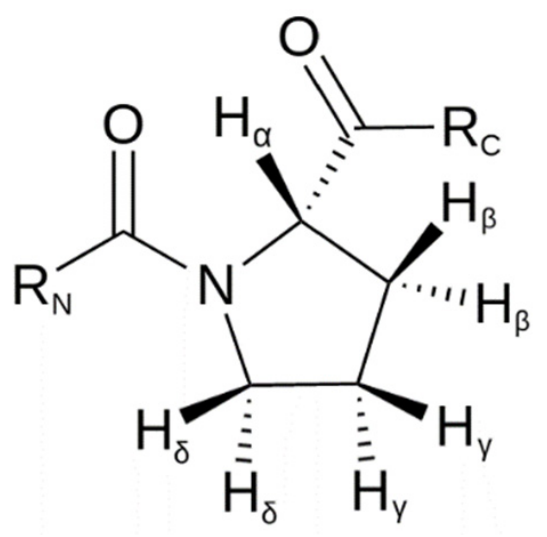
Figure 8. Hydrogens in proline.